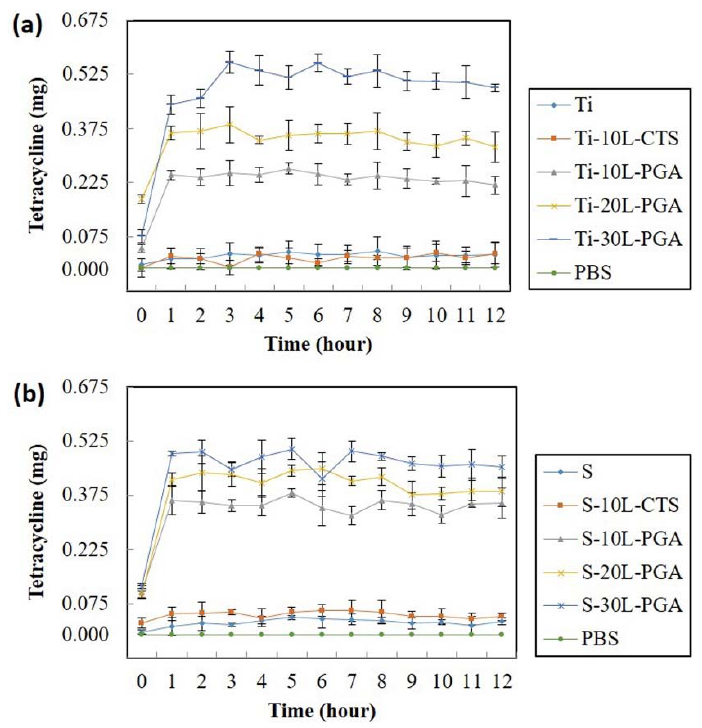
Figure 8. The release of tetracycline from ( a ) Ti6Al4V and ( b ) 316LSS substrates with different layers of PEMs coating.